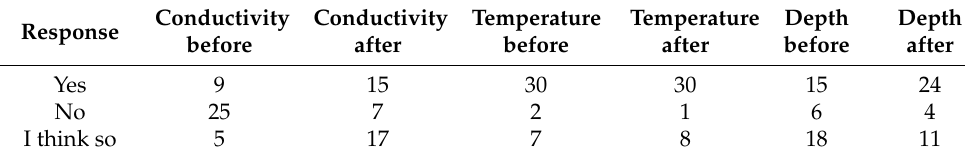
Table 4. Student knowledge of what a sensor is